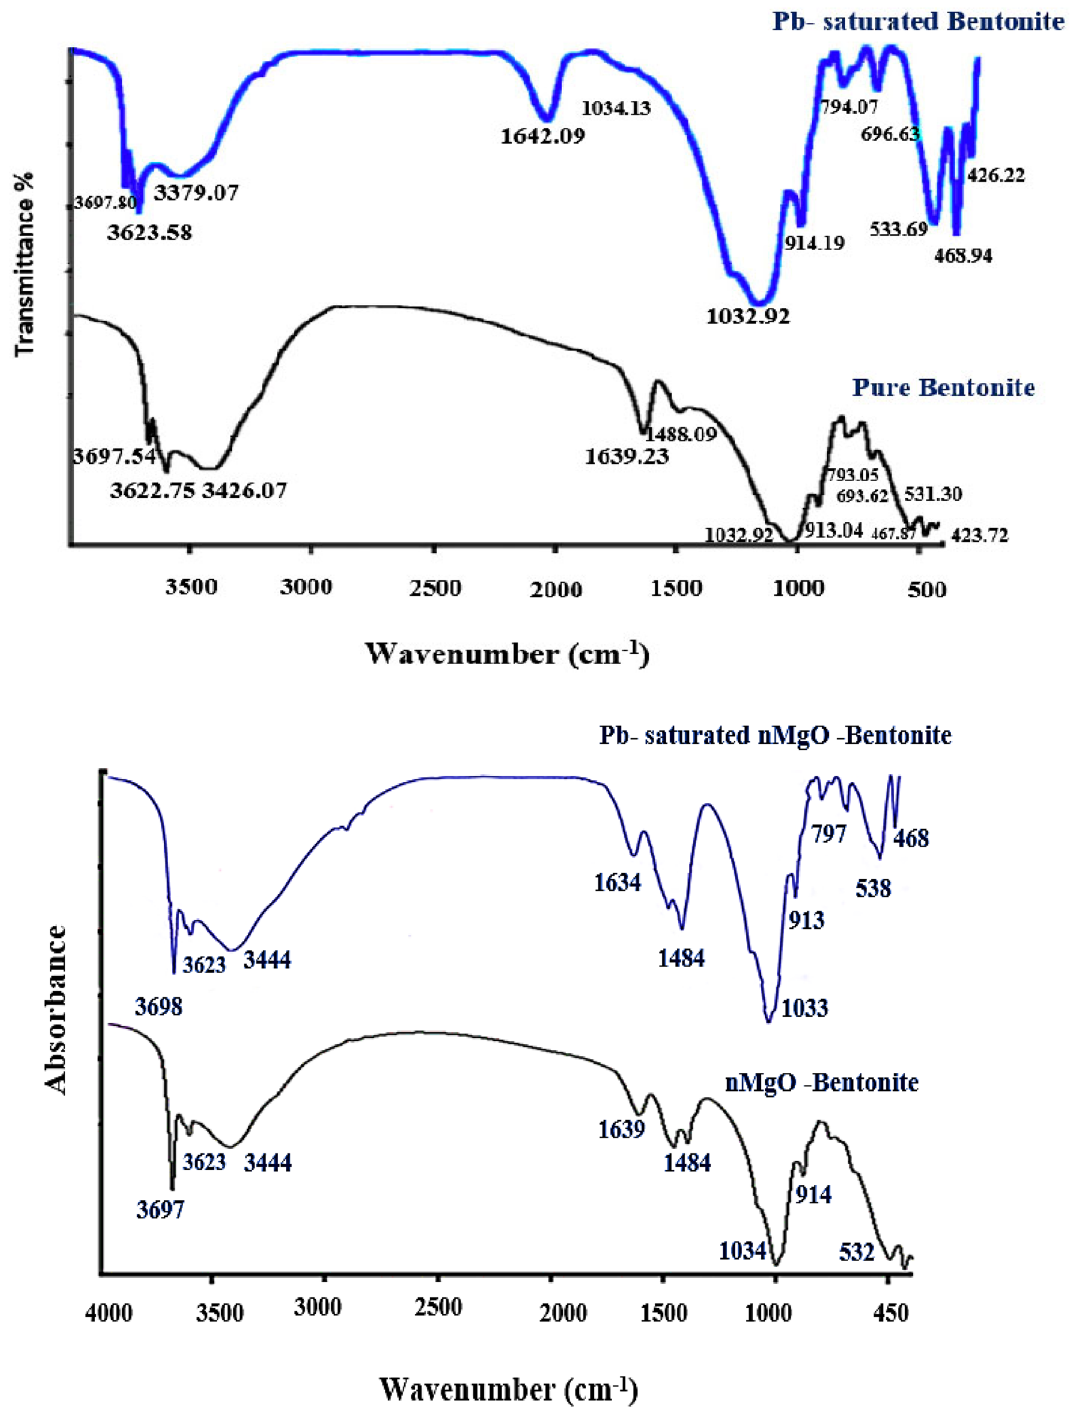
Figure 3. FTIR spectra of bentonite (above) and nanocomposite (bottom) before and after Pb(II)